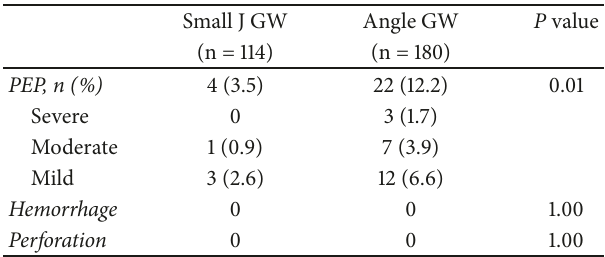
Table 4: The rate of